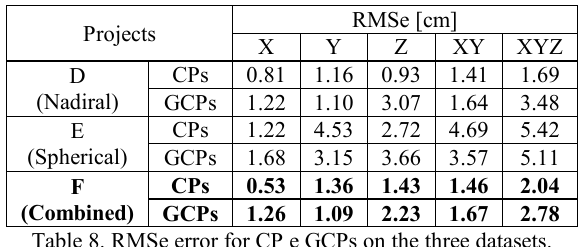
Table 8. RMSe error for CP e GCPs on the three datasets.